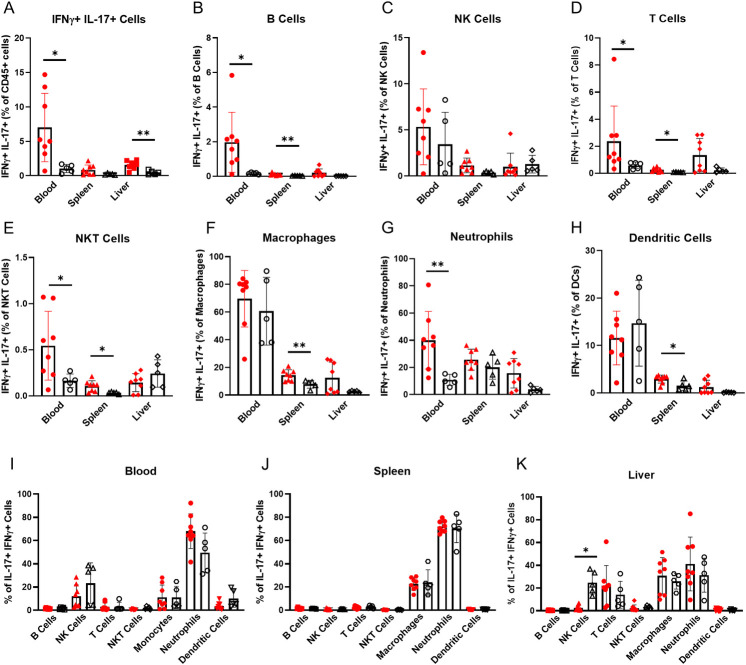
Immune cells co-expressing IFN-γ and IL-17 are significantly increased in alcohol dependent mice.(A) Co-expression of IFN-γ and IL-17 in blood, spleen, and liver CD45+ cells isolated from alcohol dependent (red, solid fill) and non-dependent (black outline, white fill) mice. (B-H) Expression of IL-17 by (B) B cells, (C) NK cells, (D) T cells, (E) NKT cells, (F) macrophages, (G) neutrophils and (H) dendritic cells in dependent and non-dependent mice. (I-K) Immune cells as percentages of all IFN-γ+ IL-17γ+ CD45+ cells in (I) blood, (J) spleen and (K) liver isolated from dependent and non-dependent mice. *, p<0.05; **, p<0.01 analyzed by Mann-Whitney U test; n = 5–8.